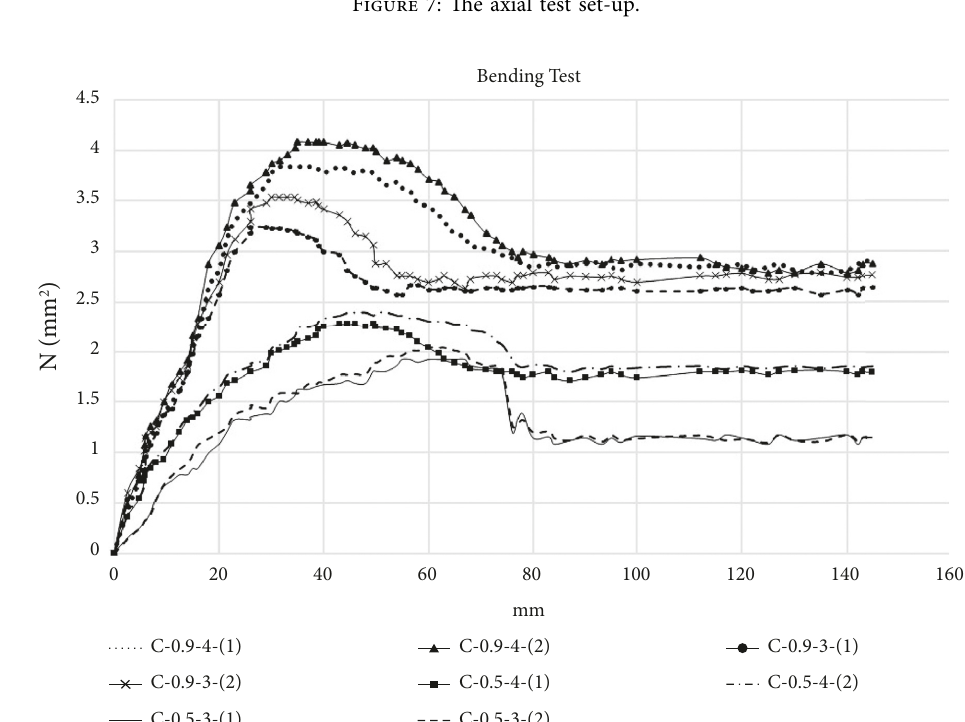
Figure 8: The tension-displacement diagram in the bending test for 8 composite panels filled with foamed